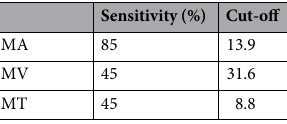
Table 3. Sensitivity of mean blur rate in all compartments at 95% specificity. (MA) Mean blur rate in all area of interest. (MV) Mean blur rate in area of big vessels. (MT) Mean blur rate in area of